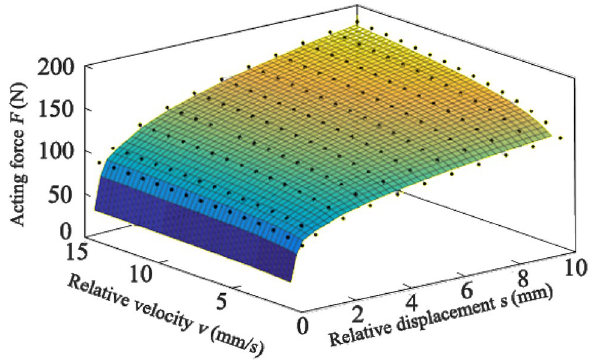
Figure 6. The axial load of the clamp against displacement s and velocity v .